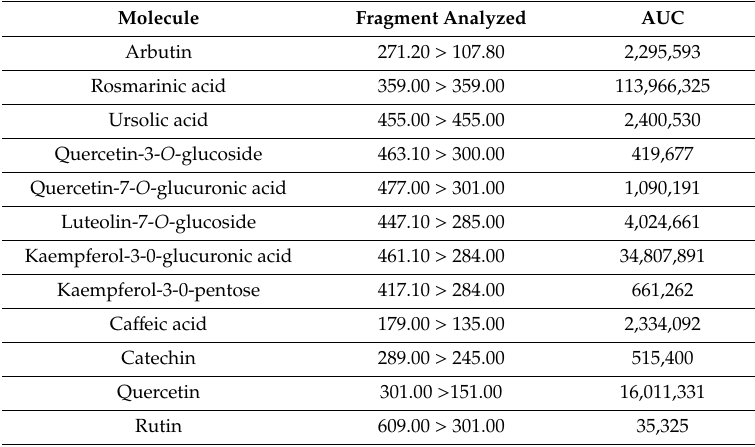
Figure 3. LC / MS results of OMP based on the Area Under Curve (AUC) of the molecules. Figure 3. LC/MS results of OMP based on the Area Under Curve (AUC) of the molecules. Table 3. LC / MS-MS identified composition of